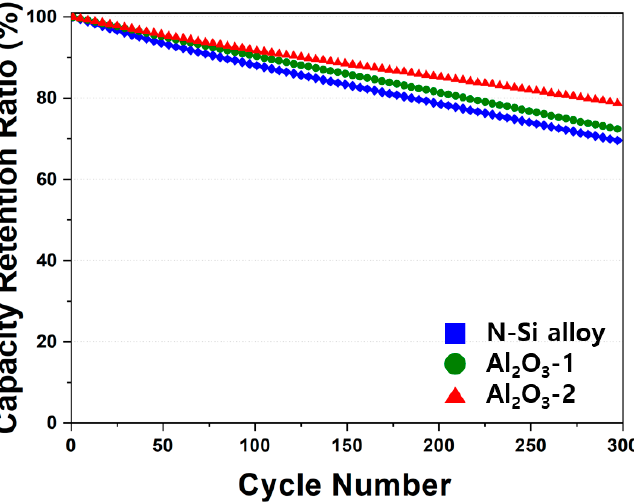
Figure 10. Cyclic performance of the N-Si alloy Al 2 O 3 -1 and Al 2 O 3 -2 powders.